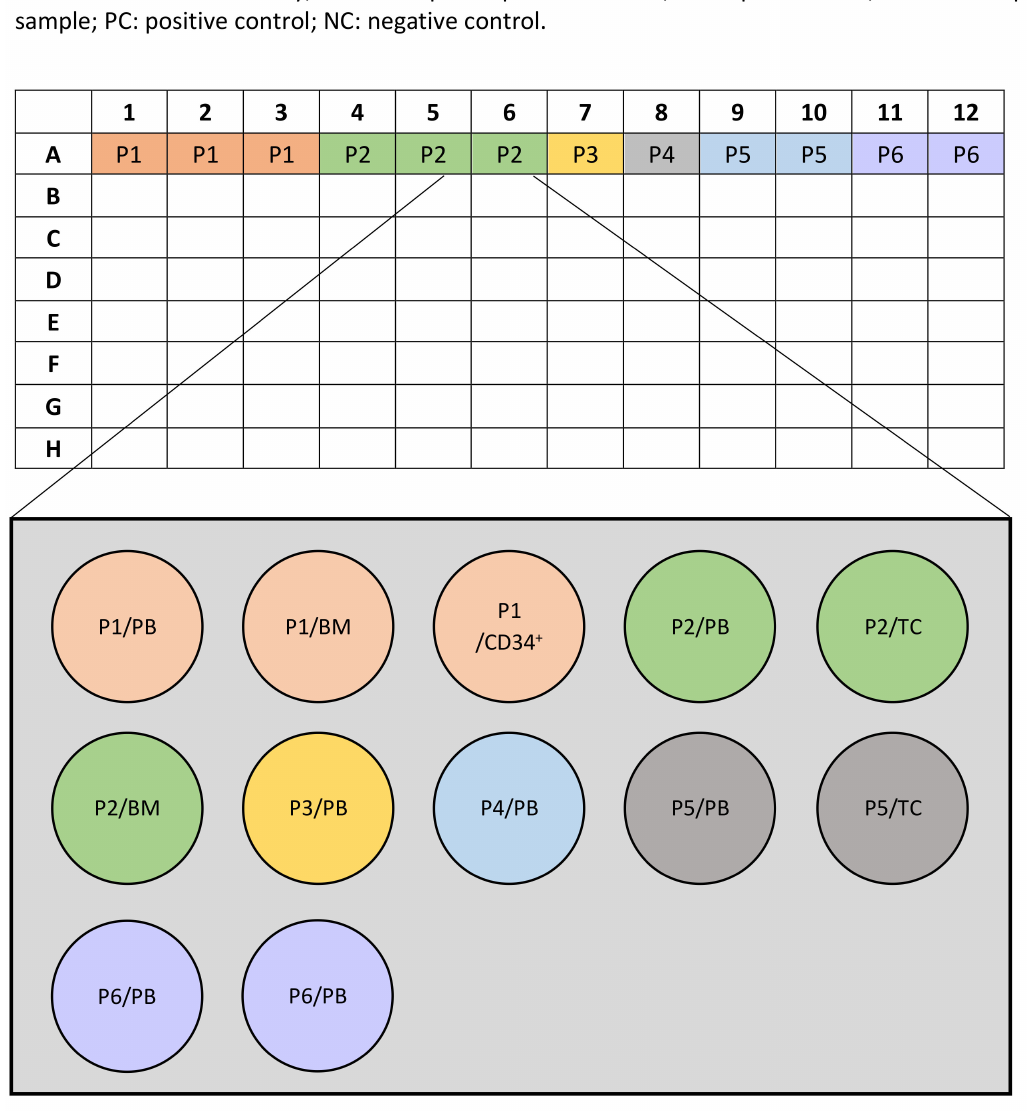
Figure 4. Example of plate setup for chimerism analysis of 6 patients with qPCR (top) and STR-PCR